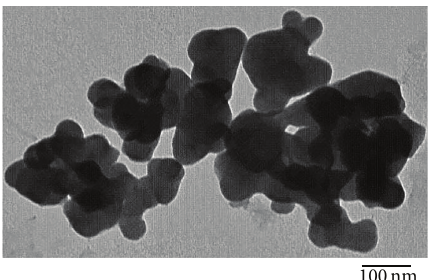
Figure 16: The transmission electron microscope of POPDA.